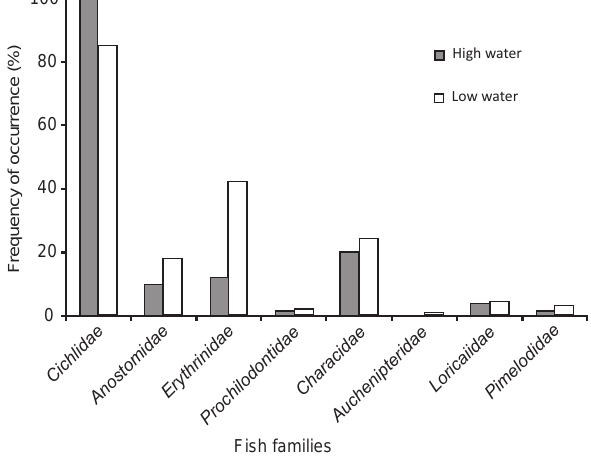
Figure 5. Seasonal analyses of the fish families (frequency of oc- currence) found in fresh feces samples of giant otters from Balbina hydroelectric reservoir (N = 75 samples) during two entire hydro- logical cycles